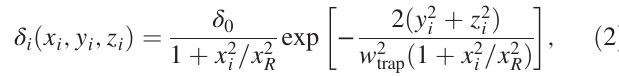
FIG. 4. Release of the light stored in subradiant excitations. (a) Experimental realization, each time trace represents an experimental sequence where the inhomogeneous broadening is applied at a different time, highlighted by the respective arrows. (b) Histogram of the decay times of the collective modes evaluated from the eigenvalues of the interaction matrix for 5000 atoms with the same density distribution as in the experi- ment, for ten realizations. Red (blue) histograms are calculated with (without) inhomogeneous broadening. (c) Results of the mean-field nonlinear coupled dipole simulations. Dashed lines: temporal evolution of the total excited state population p ð t Þ . Solid lines: intensity − dp=dt emitted in a 4 π solid angle. Purple lines: case where the inhomogeneous broadening is applied at t ¼ 12 . 5 = Γ 0 . Blue lines: no inhomogeneous broadening